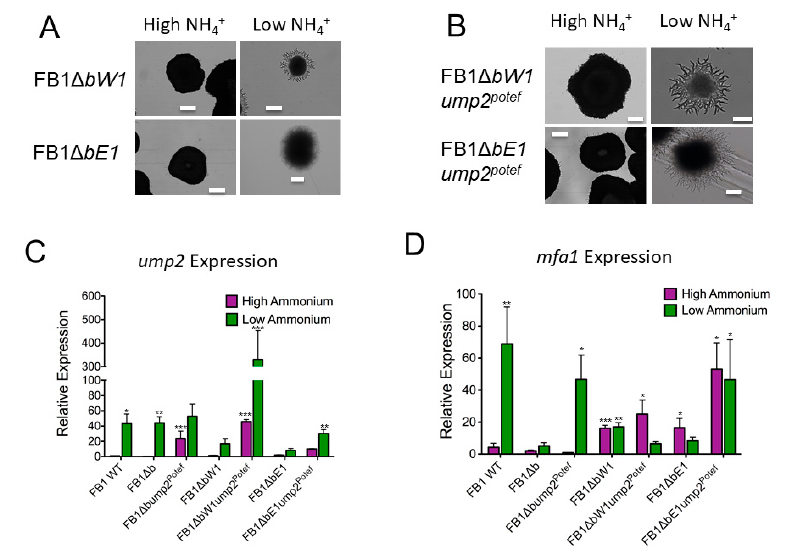
Figure 3. Partial b deletion and overexpression of ump2 in partial b deletion backgrounds. ( A ) Both bW1 and bE1 deletions show a reduction of filaments under Low-NH 4 conditions. Size bars, 200 µ m. ( B ) Constitutive expression of ump2 in a bW1 deleted background results in increased filamentation, although the phenotype was slightly different, with very thick filaments. The overexpression of ump2 in a bE1 deleted background resulted in rescue of the visually normal phenotype (i.e., filamentous on Low-NH 4 ). Size bars, High NH 4 , 200 µ m; Low NH 4 , 100 µ m. ( C ) qRT-PCR analysis of ump2 expression. In FB1 WT, ump2 is upregulated when the haploid strain is plated on Low-NH 4 media. A similar trend is observed in the complete b deletion strain. Both partial b deletion mutants show no significant difference in ump2 expression as compared to FB1 WT on High NH 4 media. While ump2 overexpression markedly increases overall ump2 transcript level in the bW1 deleted background, a similar trend is not observed in the bE1 deletion background. ( D ) qRT-PCR analysis of mfa1 expression. FB1 WT shows dramatically increased mfa1 expression under Low-NH 4 conditions as compared to the same strain on High NH 4 . While this phenotype is abolished in the complete b deletion mutant, overexpressing ump2 increases mfa1 expression on Low NH 4 in the b deletion background. Deleting bW1 results in increased levels of mfa1 on both high and Low NH 4 as compared to FB1 on High-NH 4 media. Overexpression of ump2 in a bE1 deleted background results in high levels of mfa1 under both media conditions. High-NH 4 media contains 50 mM ammonium sulfate, while Low-NH 4 media contains 50 µ M ammonium sulfate. Changes in gene expression are averages of at least three biological replicates and are displayed as log2-fold changes ± S.D., relative to expression of wild-type FB1 on High NH 4 . Relative expression of each strain and/or condition was compared to the reference strain. All of the analyses were done using a one-way ANOVA with a Dunnett’s multiple comparison post hoc test. (* p < 0.05, ** p < 0.01, and *** p < 0.001). As overexpression of ump2 in a strain with the entire b mating type locus